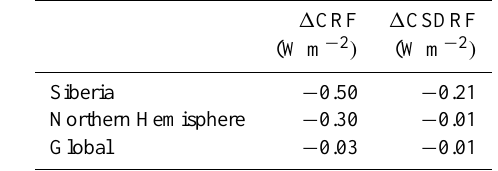
Figure 4. Relative increase in SOA mass, simulated by ECHAM5- HAM in different aerosol size modes due to BVOC emissions in- crease from the year 2000 to 2100. The areas are averaged over Siberia, and the BVOC emissions for years 2000 to 2100 (exam- ple is for E ∗ =1 . 9). Areas were separated by wildfire emissions (us- ing an emission limit of 10 − 11 kg m − 2 s − 1 ) . In the Siberian do- main, accumulation mode includes over 85% of organic aerosol, and the absolute changes in SOA are also dominated by accumu- lation mode. However, the SOA condensation increase until year 2100 is essential for nucleation and Aitken mode growth.